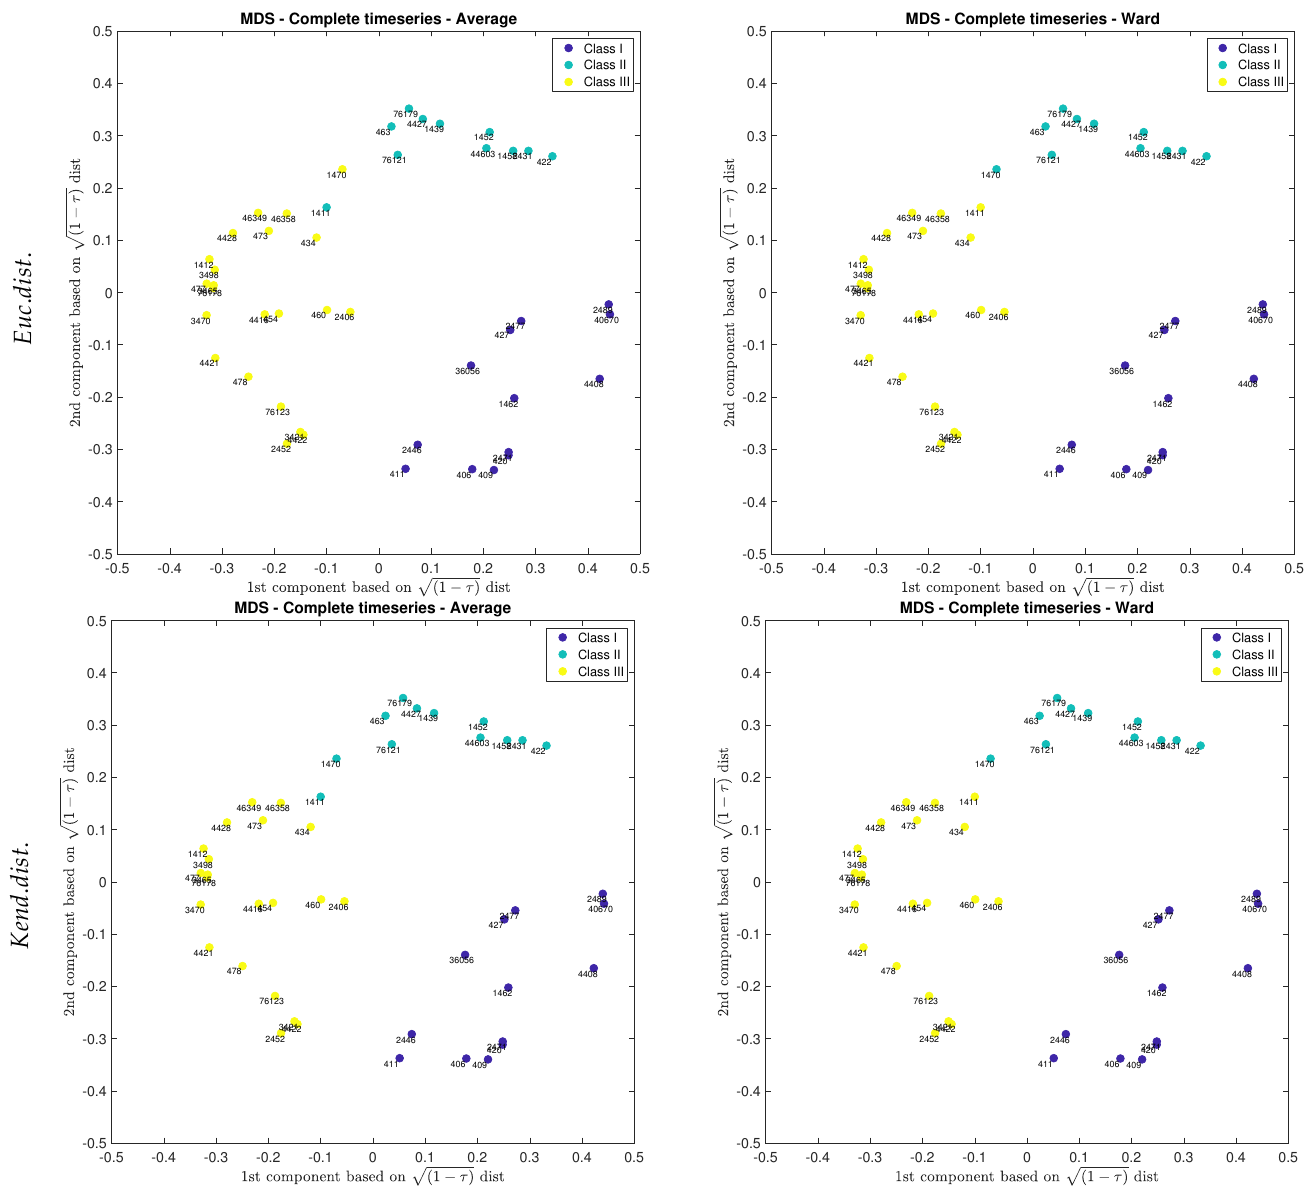
Figure 13. Comparison between multidimensional scaling and hierarchical clusters. Our result support the findings and suggestion of temporal clustering of flood study in Germany that in flood clustering more than one method has to be analyzed [28], due to the nature of each clustering method. Using the AHCT method alone does not provide fixed clusters in a catchment. To have robust clusters, another complementary clustering method is required. Despite the reported statement that the spatial patterns of flood clustering behavior are not strongly pronounced in Germany [28], our clustering results show explicit cluster behaviors in concurrent occurrences of floods in the Neckar basin in Germany. The clustering result maps partly agree with the flood clustering pattern in Germany corresponds to a time windows from 1961–1990 [34]; however, our analysis is in more detail and measurement